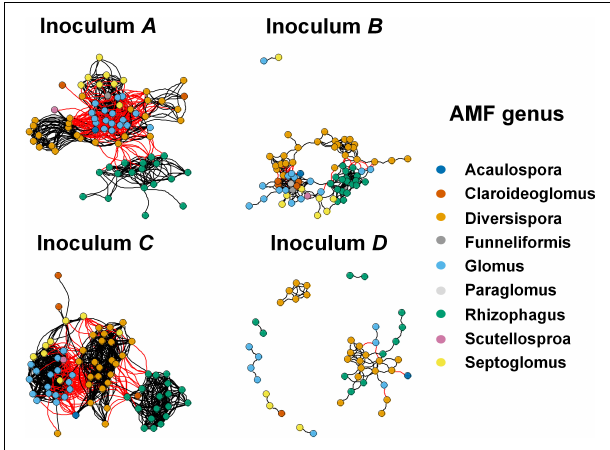
FIGURE 4 | Co-occurrence network of rhizosphere AMF communities subjected to inoculum A, B, C and D . Each node represents AMF OTU, and nodes are colored based on their membership at the genus level. A black line indicates a positive interaction between two nodes, while a red line indicates a negative